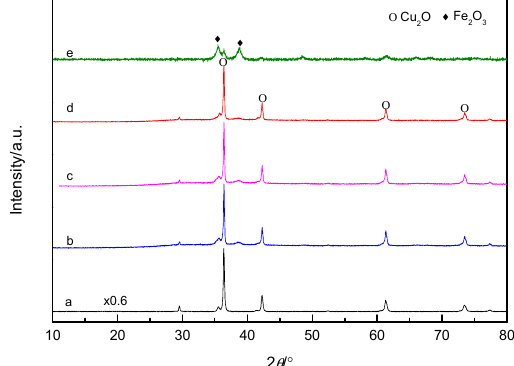
Figure 1. XRD patterns of Cu 2 O and Cu x O-Fe y O z with different Fe/Cu ratios ( a ) Cu 2 O, ( b ) CF-0.05, ( c ) CF-0.1, ( d ) CF-0.8, and ( e ) CF-2.